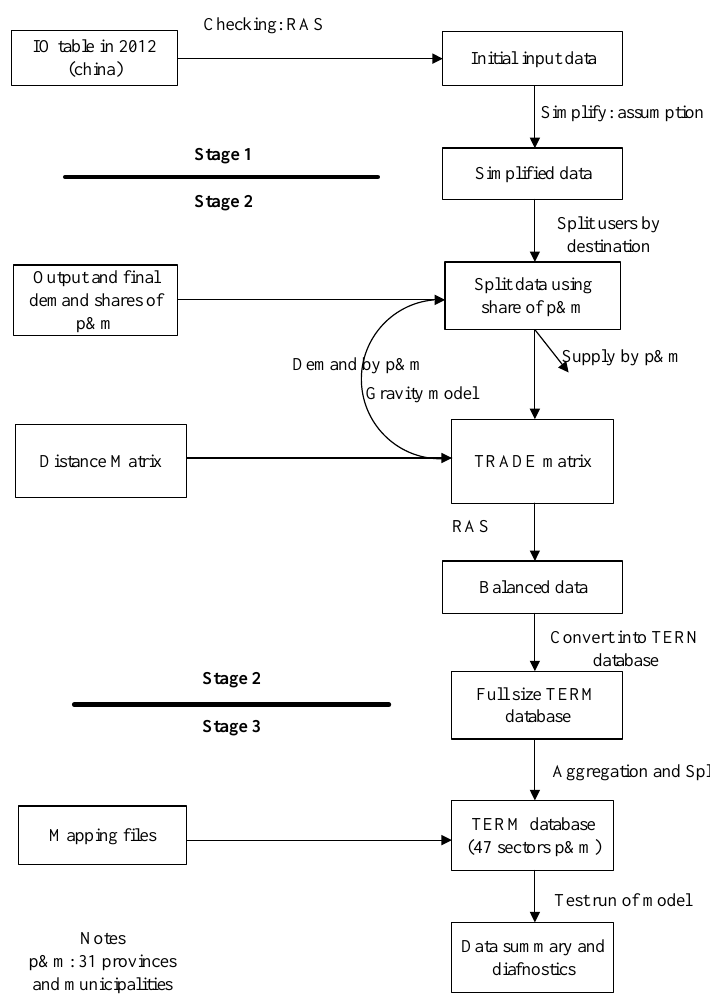
Figure 1. The three stages of constructing the TERM database used in the